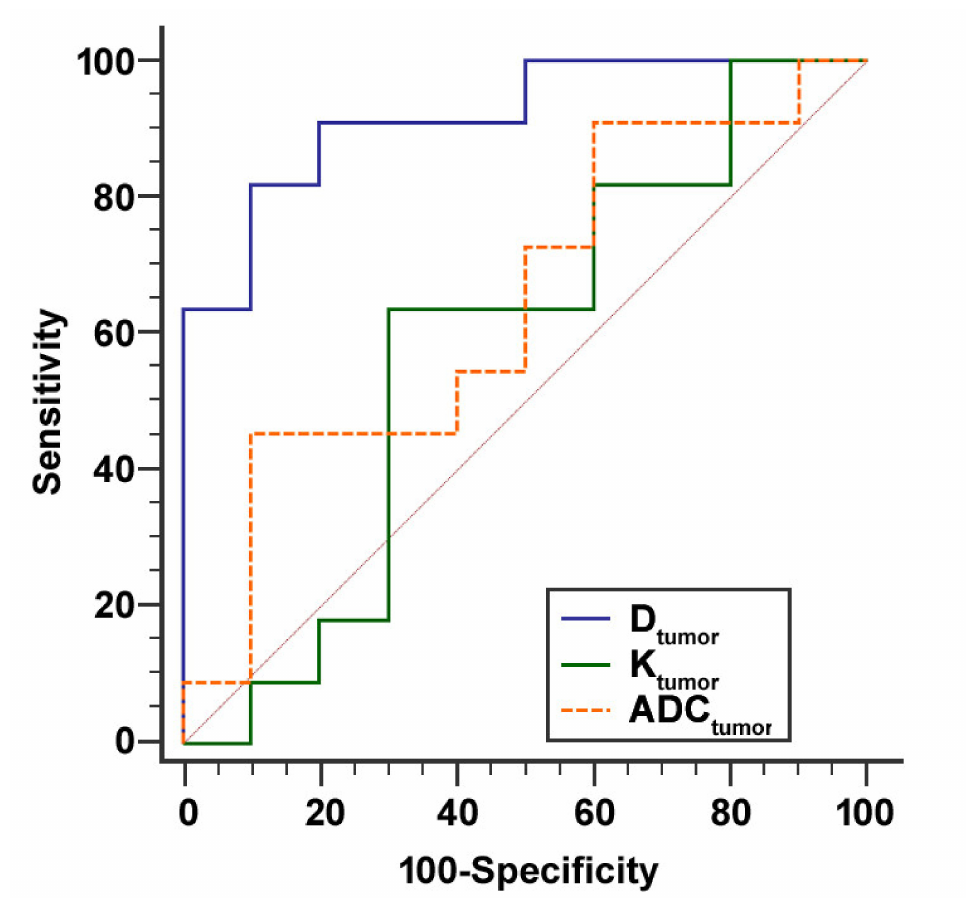
Figure 4. ROC curves for distinguishing stroma-rich from stroma-poor tumors using D tumor , K tumor , and ADC tumor . D tumor had a better performance in distinguishing tumors with stroma percentage > 50% from tumors with stroma percentage ≤ 50%, compared to K tumor and to ADC tumor